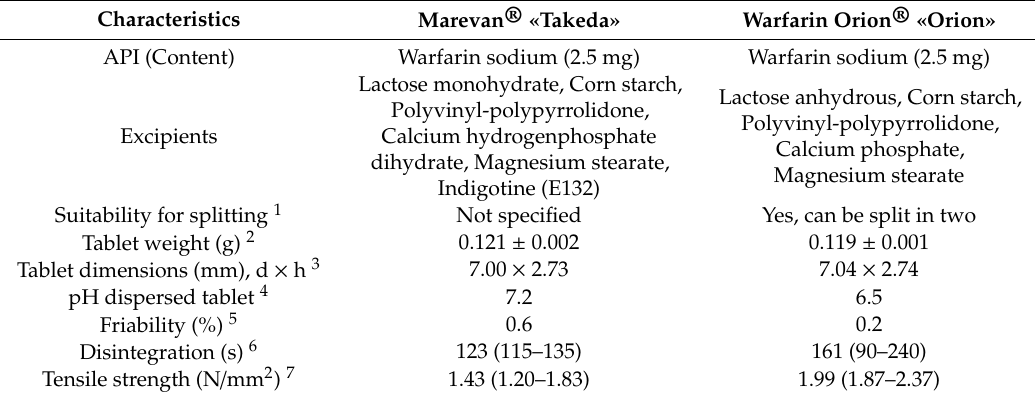
Table 1. Characteristics of the two generic warfarin tablets studied, including results of physical tests.